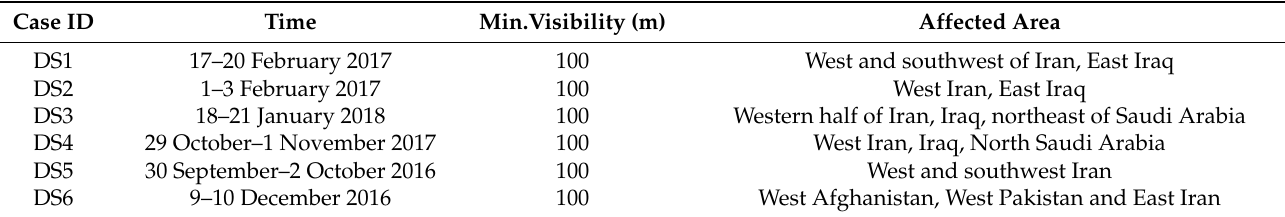
Table 1. Time of occurrence and affected areas of the six frontal dust